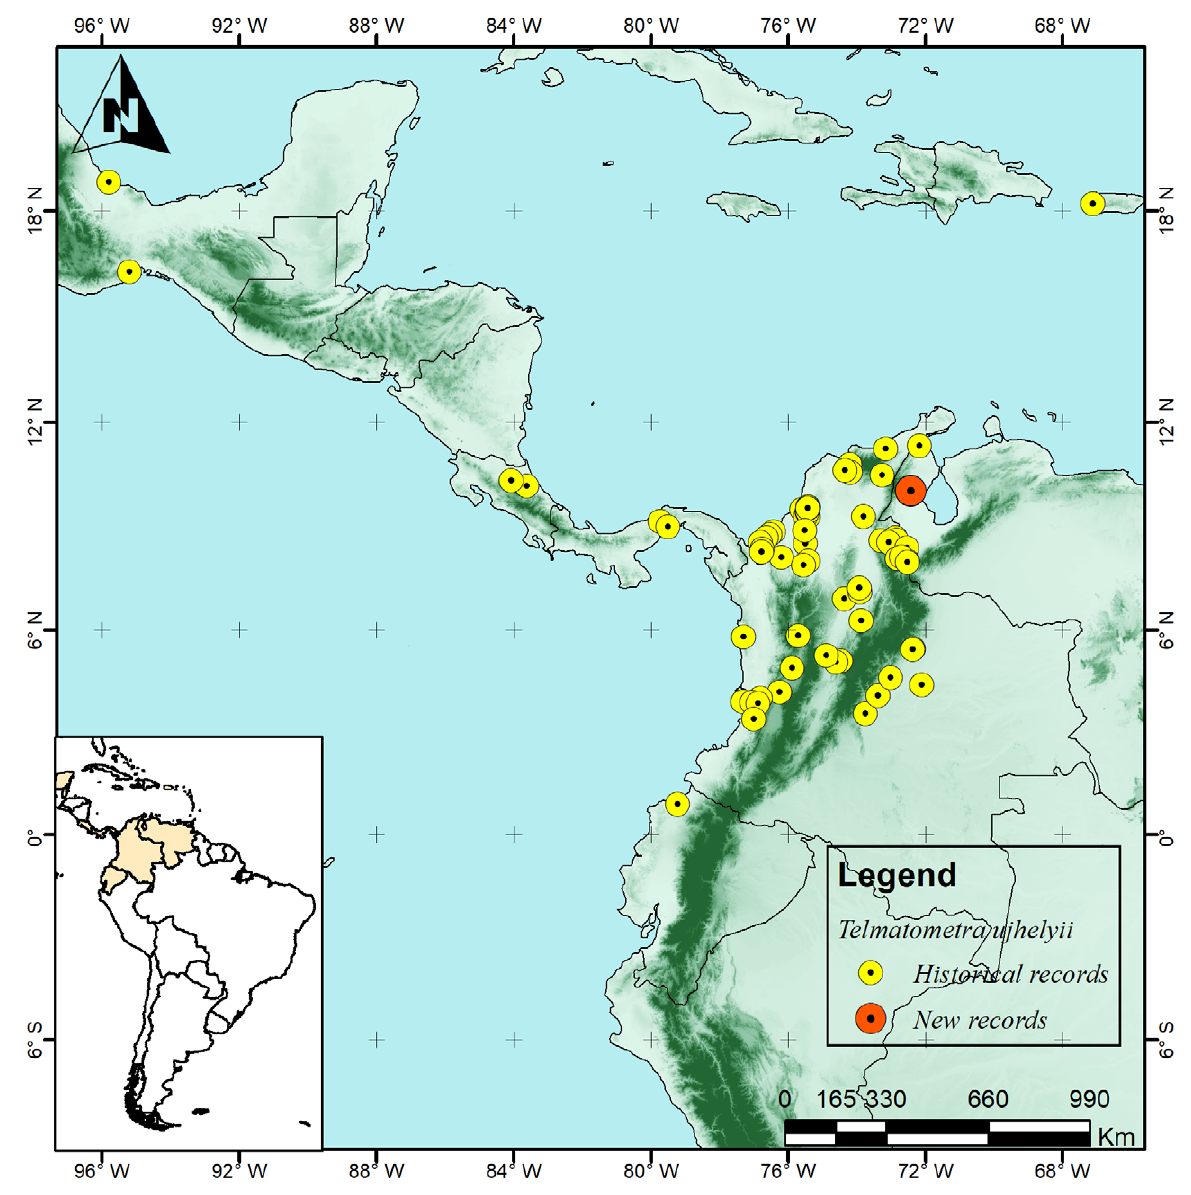
Figure 10. Historical and new records of Telmatometra ujhelyii in the